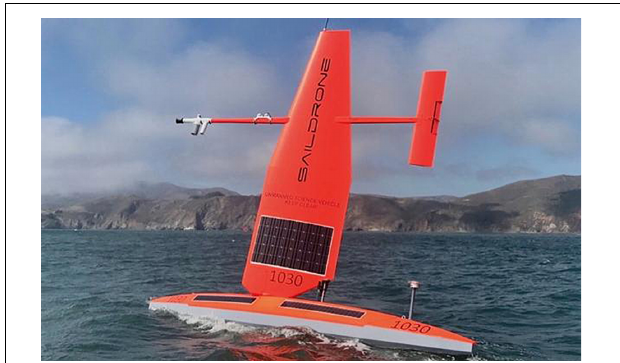
FIGURE 1 | Saildrone USV off the coast of